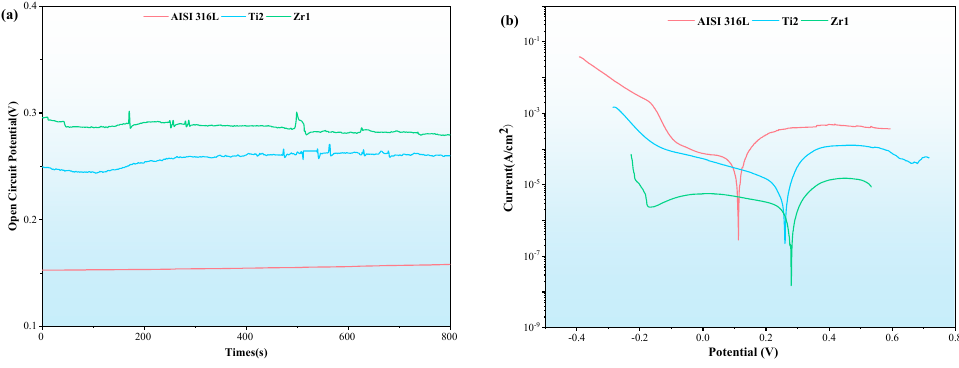
Figure 6. AISI 316L, Ti2, and Zr1 open circuit potential ( a ) and polarization curves ( b ). Table 3. Analysis of Electrochemical Parameters of Corrosive Environment Samples by Tafel Extrapolation.